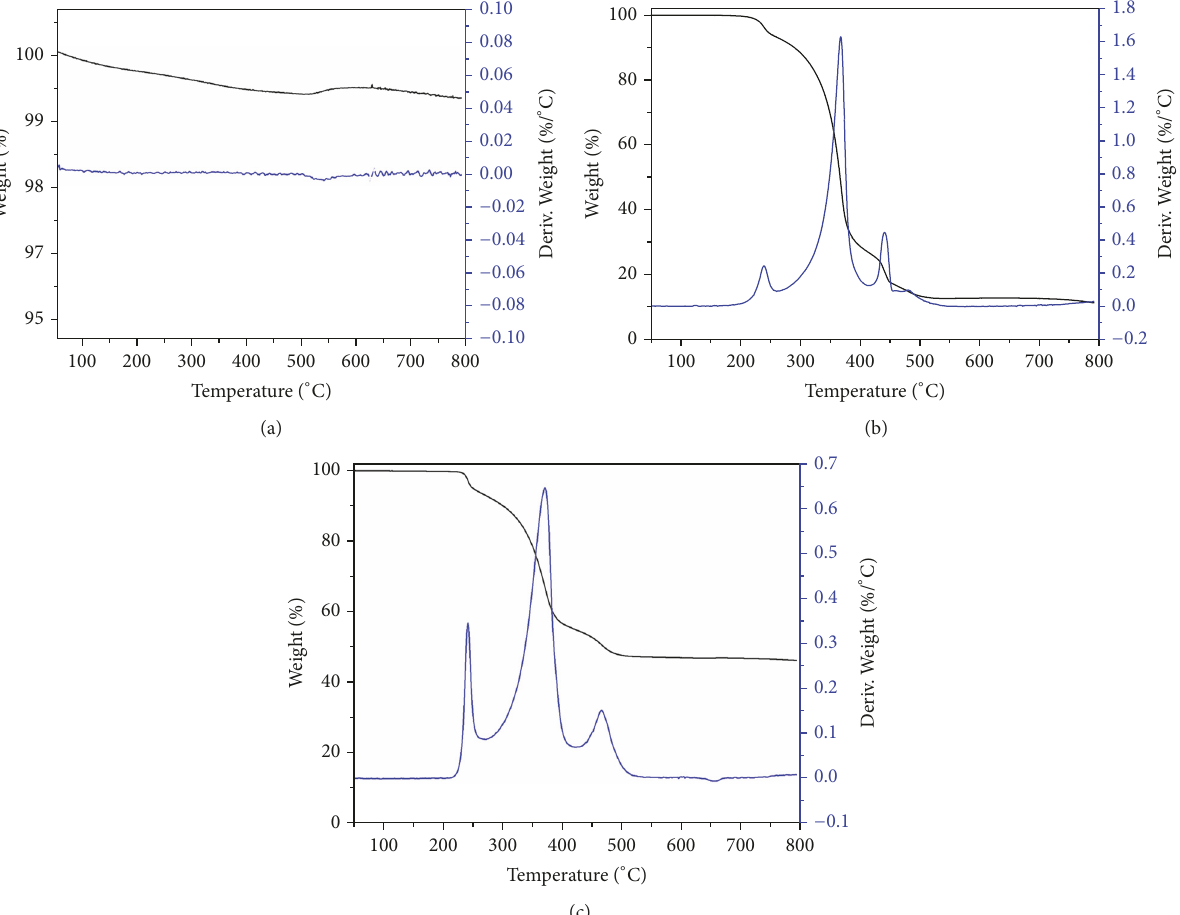
Figure 5: TG-DTG curves of (a) Sr 0.7 K 0.3 TiO 3−𝛿 ; (b) PC-polyHIPEs; and (c) Sr 0.7 K 0.3 TiO 3−𝛿 @PC-polyHIPEs.